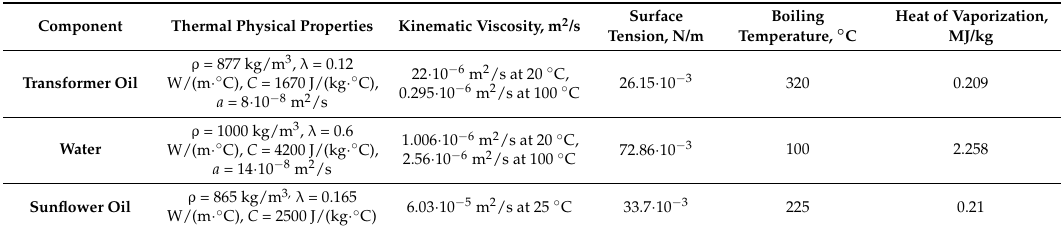
Table 2. Main properties of the liquids under study.